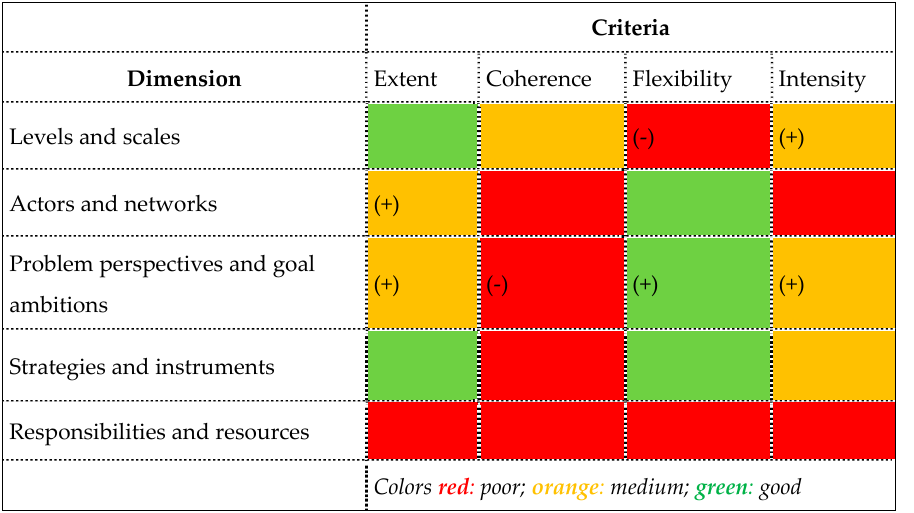
Figure 2. GAT results for the New Delhi NZEB case study.